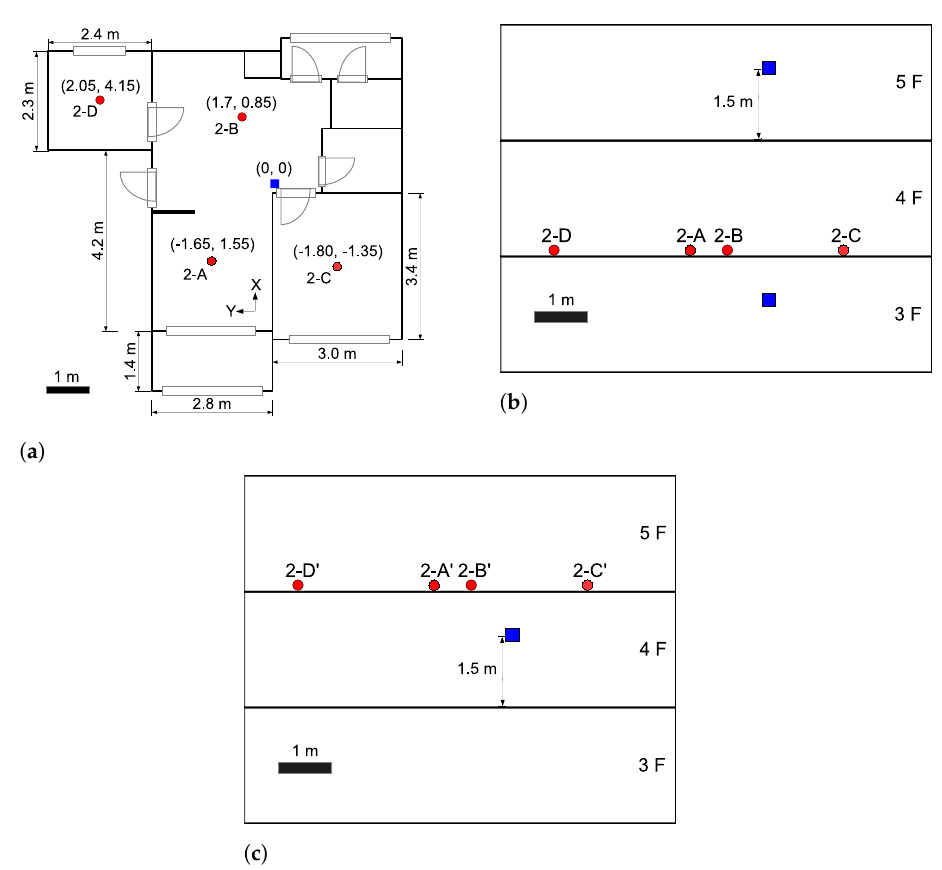
Figure 3. Noise source ( (cid:13) ) and receiver ( (cid:3) ) positions used for inter-floor noise generation at APT II. ( a ) Floor plan. ( b ) Building elevation 2 (APT 2). ( c ) Building elevation 2 (cid:48) (APT 2 (cid:48)